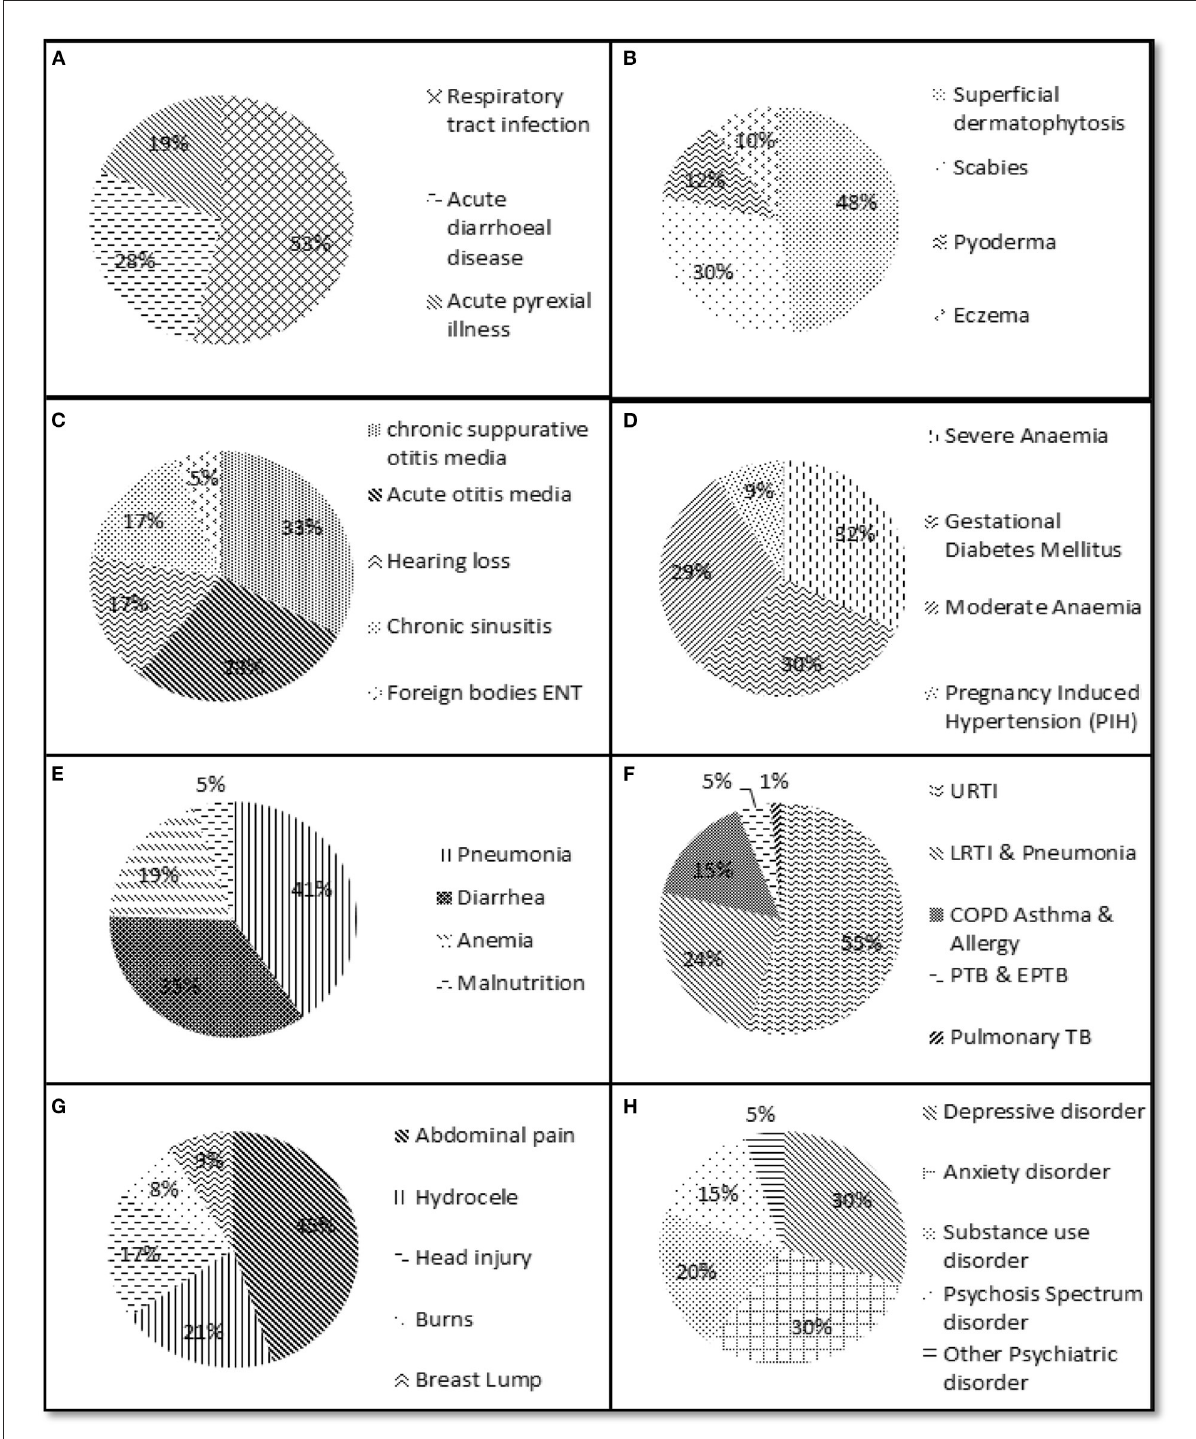
FIGURE2 Depiction of percentage of important clinical presentations/diseases reported to different departments. (A) General medicine department. (B) Dermatology department. (C) Ear, nose and throat department. (D) Obstetrics and gynecology department. (E) Pediatrics department. (F) Pulmonary medicine department. (G) Surgery department. (H) Psychiatry